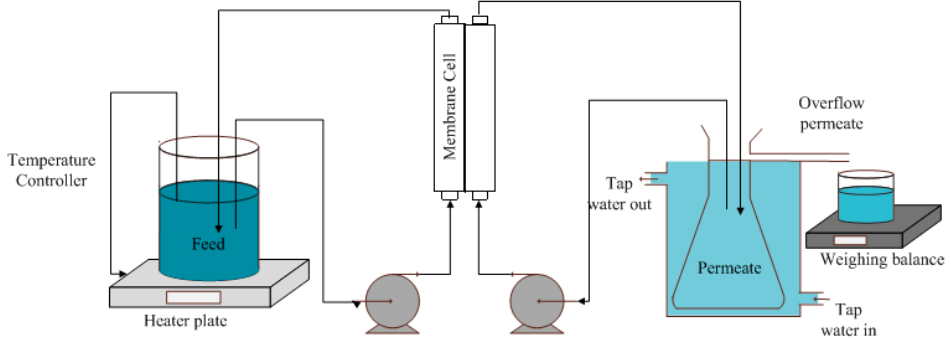
Figure 3. Illustration of experimental direct contact membrane distillation set-up.